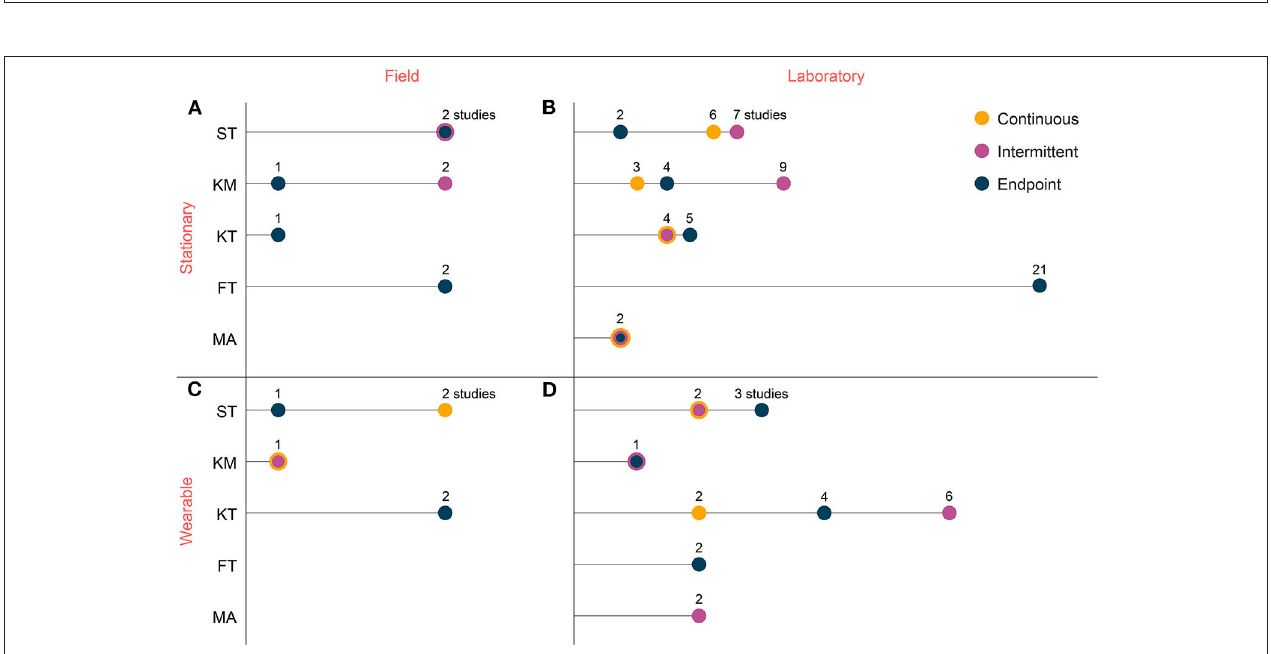
FIGURE 3 | Number of studies per parameters category grouped in terms of the timing of the measurement (continuous, intermittent, and endpoint), sensors (wearable vs. stationary), and location (field vs. laboratory). (A) Field and stationary, (B) laboratory and stationary, (C) field and wearable, and (D) laboratory and wearable. The four sub-figures do not necessarily have the same scale on the x-axis. ST, gait spatiotemporal; KM, kinematics; KT, kinetics; FT, functional test; MA, muscle activity.